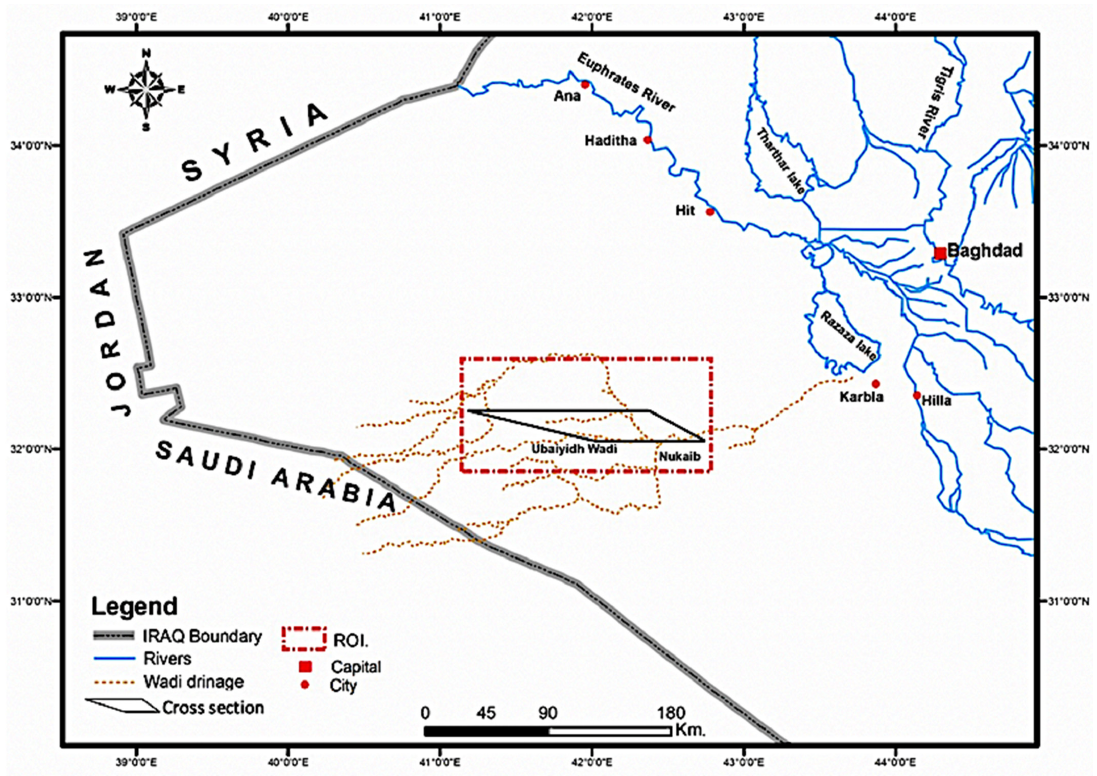
Figure 1. Precipitation from Nukaib Station 1980–2008 ( a ) Monthly means; ( b ) Annual means [16].